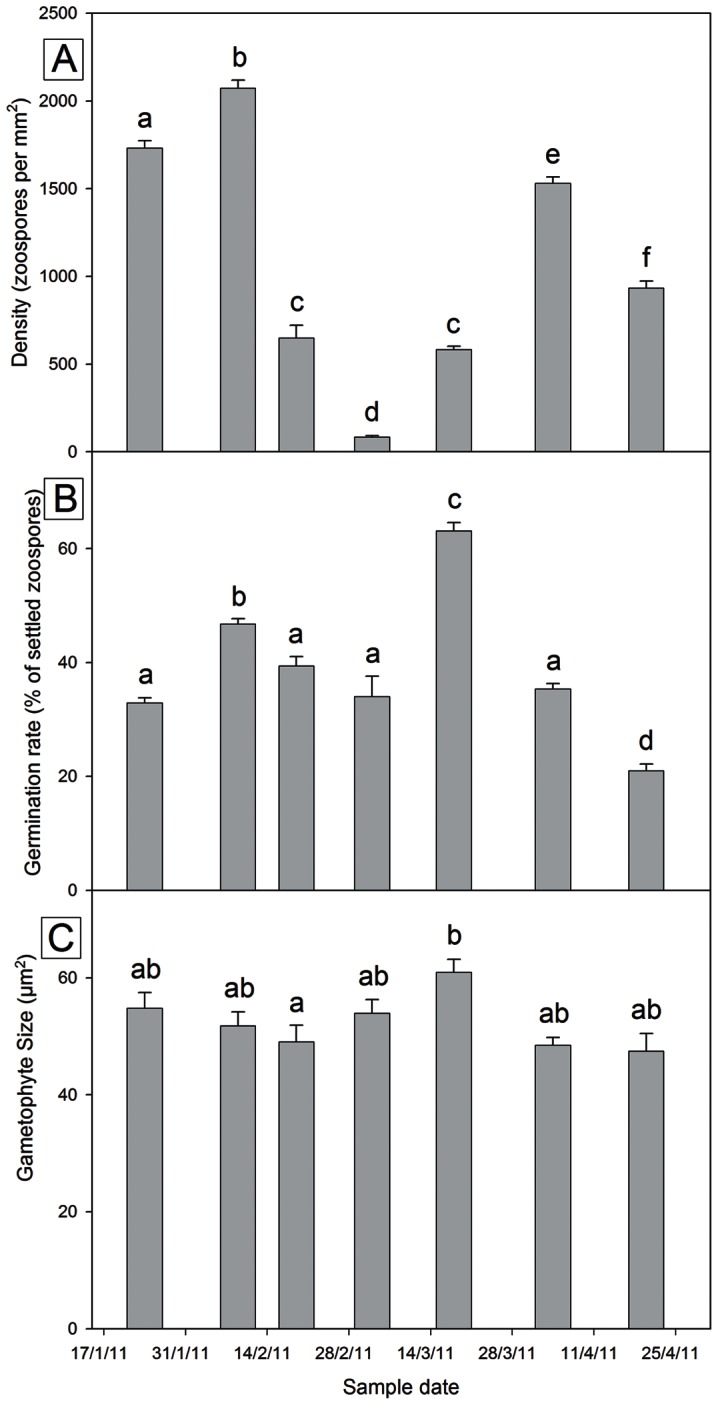
Plots of mean (±SE) measurements taken 18 hours after release.Plot A) –settlement density, B) gamete size, and C) percentage of initial density which had germinated. Within each plot, bars were allocated the same letters if they were not statistically significantly different (P>0.05).